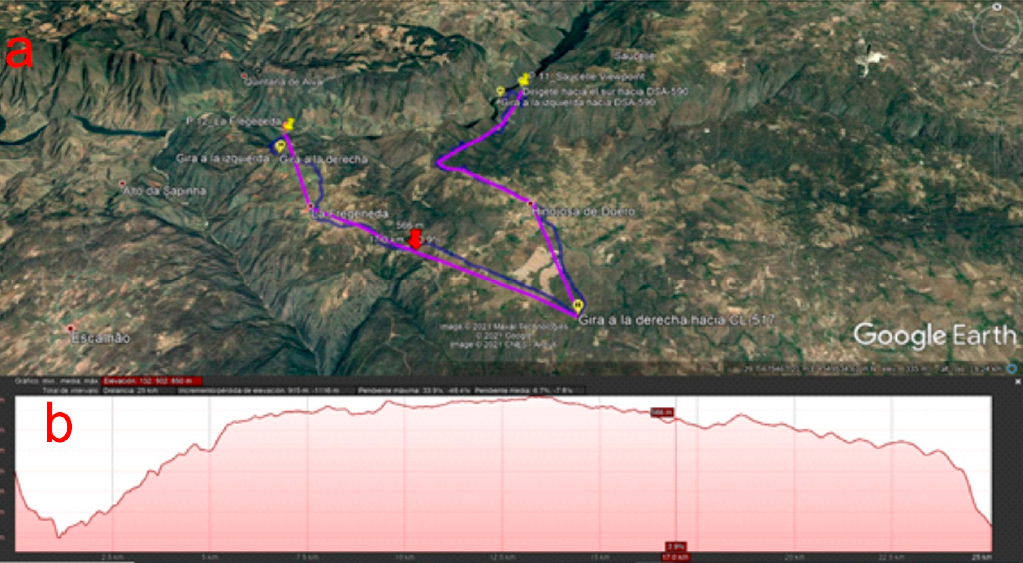
Figure 8. Route from site P-11 (Mirador de Saucelle) ( a ) to site P-12 (La Fregeneda) and topographic profile ( b ).